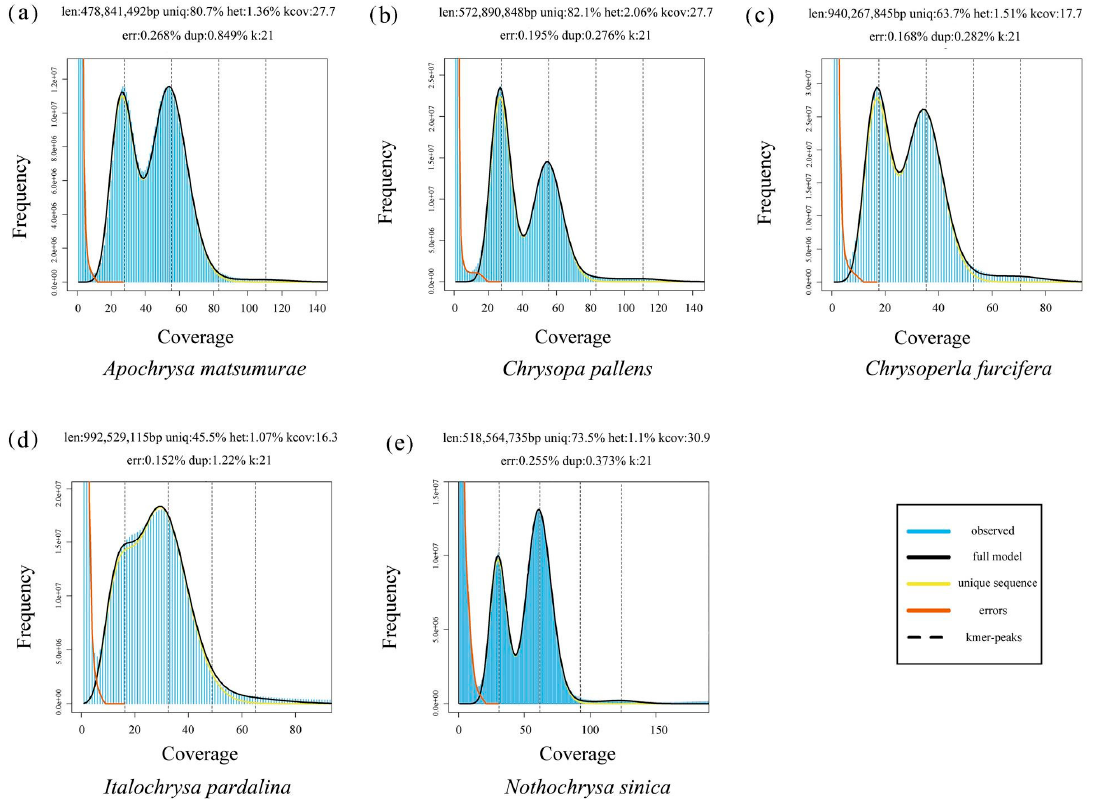
Figure 1. Characteristics of newly sequenced genomes in this study inferred using GenomeScope. len: genome haploid length; uniq: percentage of the genome unique length; het: heterozygosity; kcov: coverage of hybrid peak; err: read error rate; dup: duplicates; k: k-mer size.